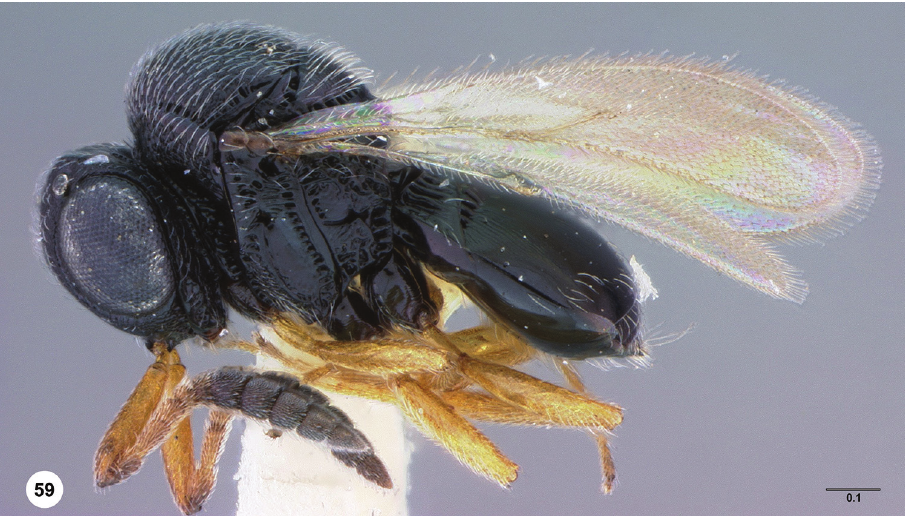
Figure 59. Trissolcus eriventus female (USNMENT00916459), head, mesosoma, metasoma, lateral view. Scale bars in